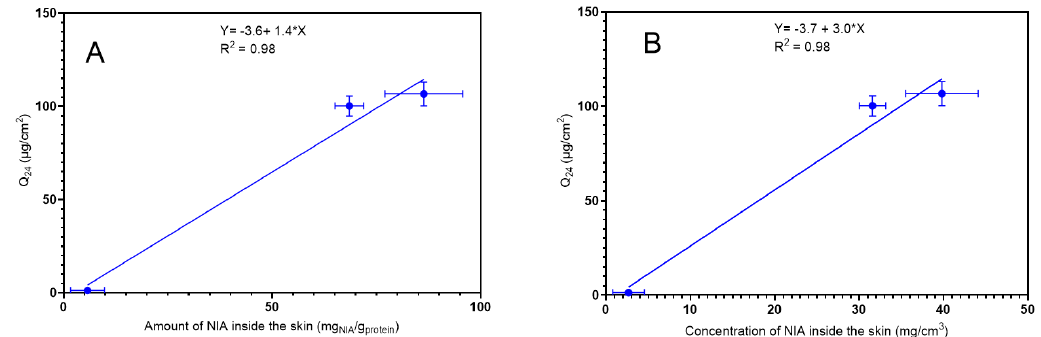
Figure 5. ( A ) Correlation of the in vitro cumulative amount of NIA permeated through human skin (4 ≥ n ≥ 3; mean ± SEM) and the in vivo amount of NIA inside the skin at 2 µm after the 60 min application of formulations ( n = 8; mean ± SEM). ( B ) Correlation of the in vitro cumulative amount of NIA permeated through human skin (4 ≥ n ≥ 3; mean ± SEM) and the in vivo concentration of NIA inside the skin (mg/cm 3 ) at 2 µm after the 60 min application of formulations ( n = 8; mean ± SEM).